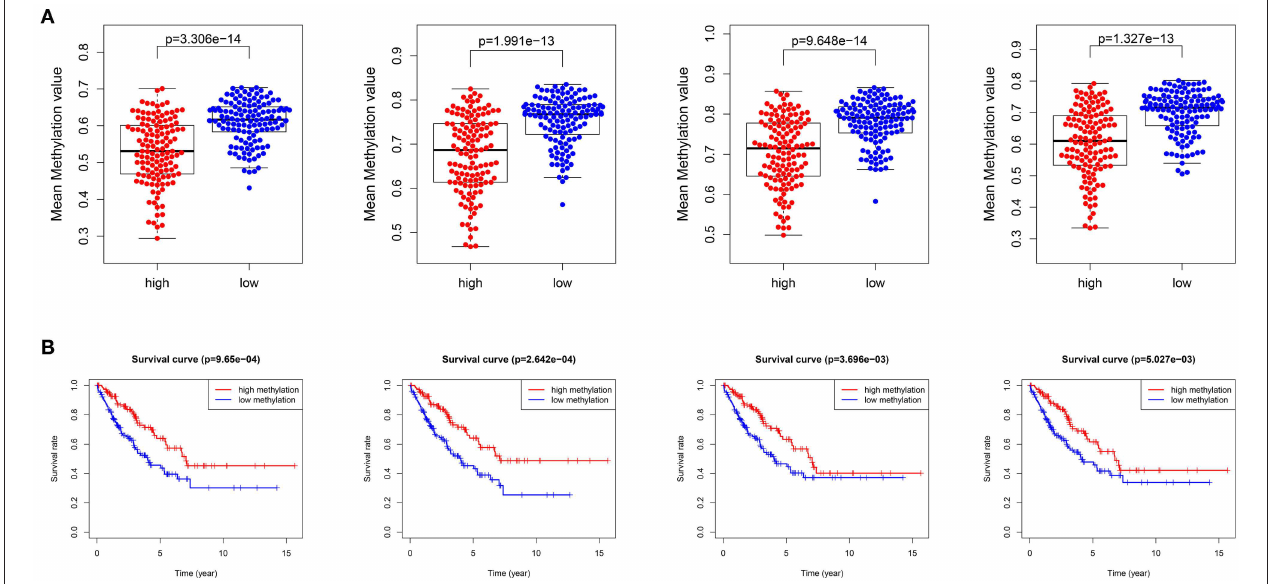
FIGURE 8 | DNA methylation analysis for STS. (A) Differences in the mean methylation value in the promoter, body, 3 ′ untranslated regions (3 ′ UTR), and intergenic regions (IGR) (from left to right) between high- and low-risk patients. (B) Survival curves for patients with high and low methylation in the promoter, body, 3 ′ UTR, and IGR (from left to